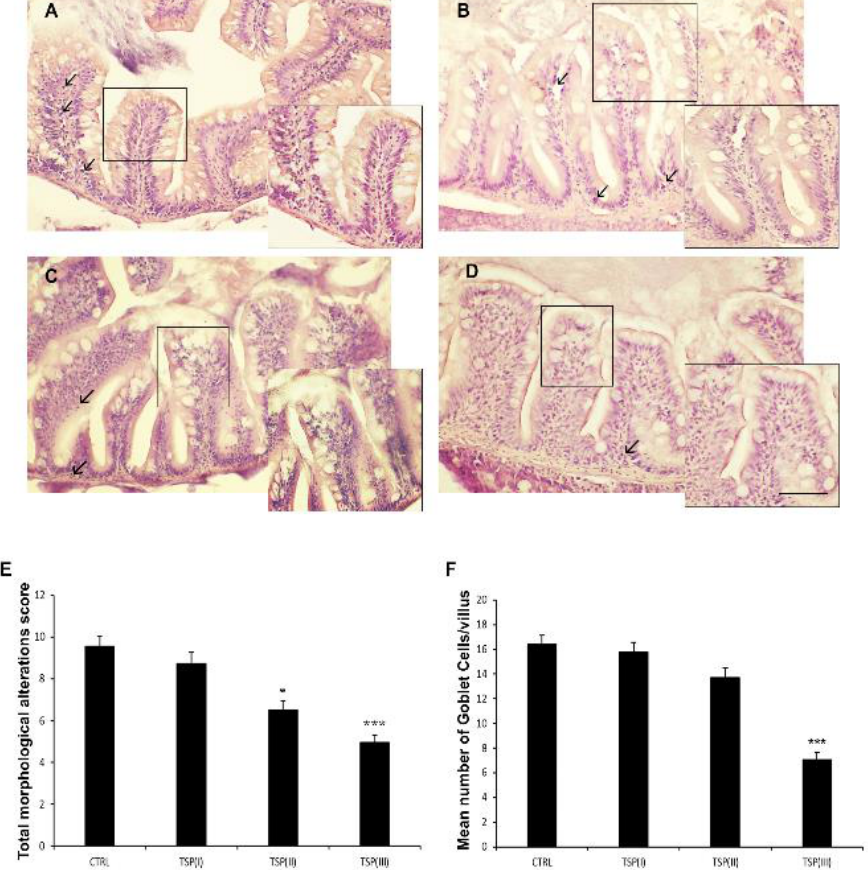
Figure 1. Hematoxylin and eosin (H&E) staining of intestines of ( A ) zebrafish fed a plant-based diet (control); ( B ) TSP I, zebrafish fed a plant-based diet supplemented with TSP at 0.9 g/kg of feed; ( C ) TSP II, zebrafish fed a plant-based diet supplemented with TSP at 1.7 g/kg of feed; and ( D ) TSP III, zebrafish fed a plant-based diet supplemented with TSP at 3.4g/kg of feed. Scale bar: 100 µ m; 50 µ m for the higher magnifications. Arrows indicate leucocyte infiltrates; linear boxes depict goblet cells. ( E ) Bar graph showing the total morphological alteration score (based on the modification of intestinal folds and gut lumen and increases in the numbers of goblet cells and leukocytes) defined for the intestines of each zebrafish group. Data are expressed as means ± SEs. * p < 0.05, *** p < 0.0001 compared to the control group. ( F ) Bar graph showing the mean number of goblet cells/villi in the intestines of each zebrafish group. Alcian Blue staining was used to count the goblet cells. Data are expressed as means ± SEs. *** p < 0.0001 compared to the control